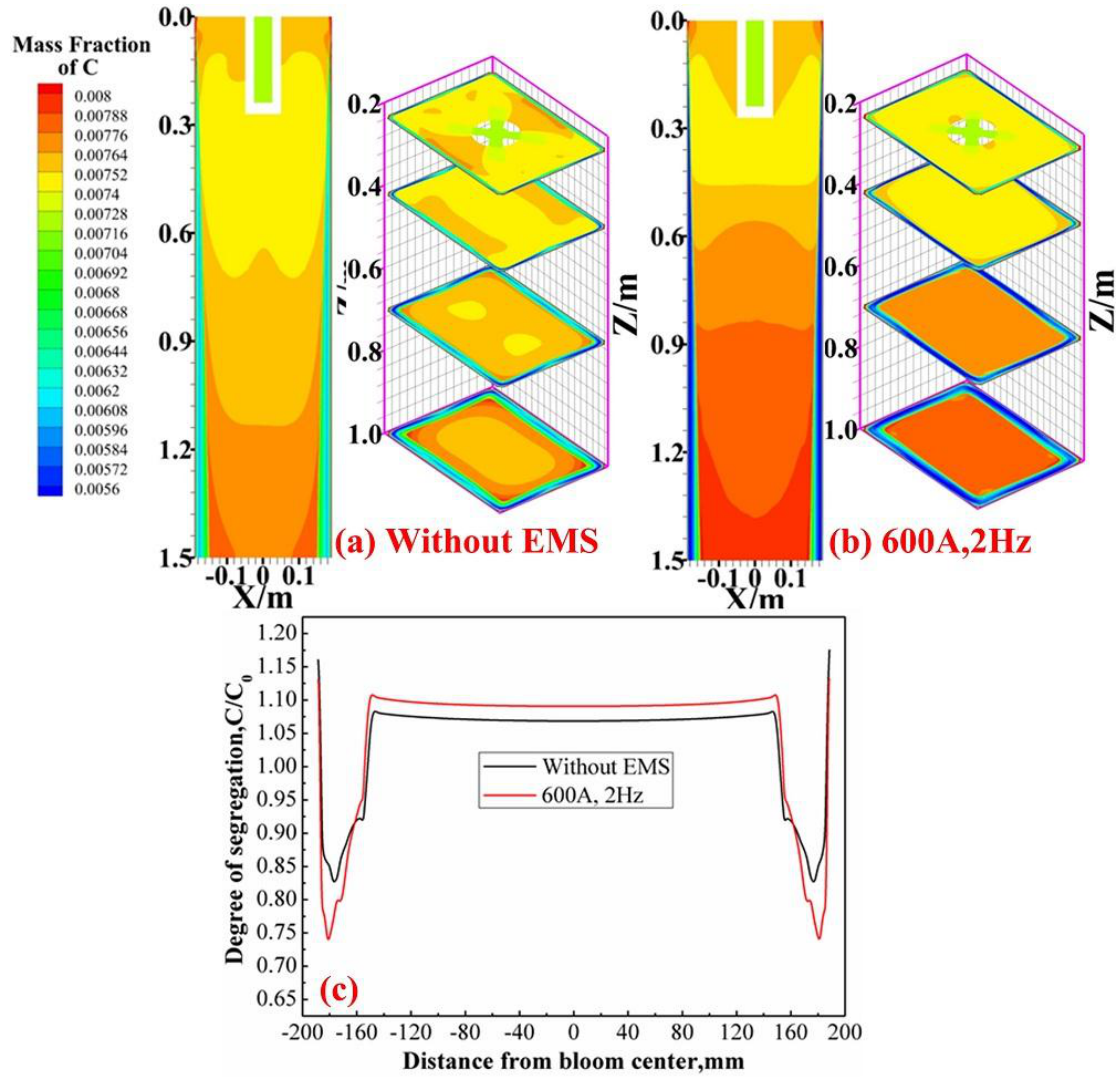
Figure 14. Distributions of solute element C on the y – z plane, at various cross sections of the bloom ( a , b ), and the centerline of the computational outlets ( c ).